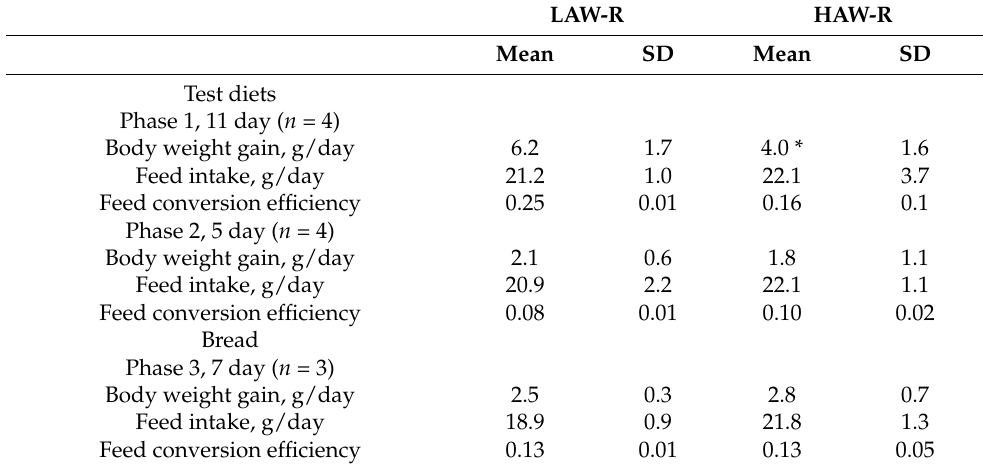
Table 3. Body weight gain, feed intake and feed conversion efficiency in ileorectomised